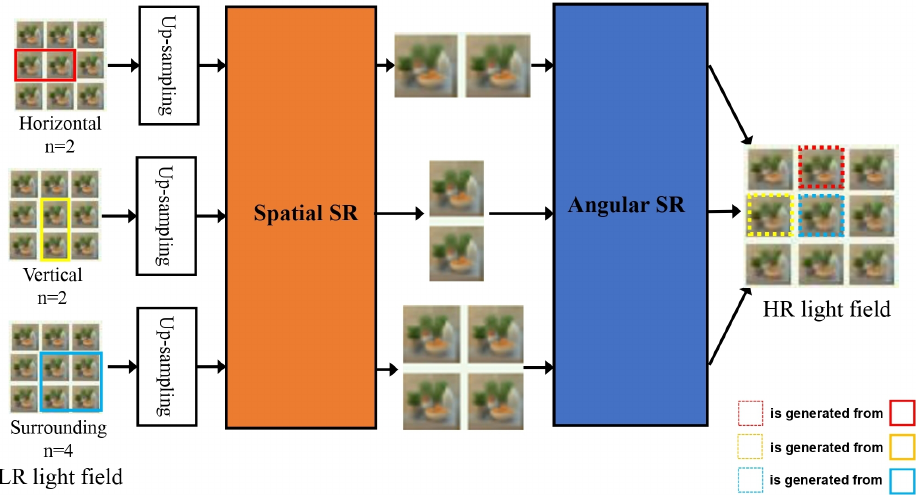
Figure 5. Overall framework of LFCNN